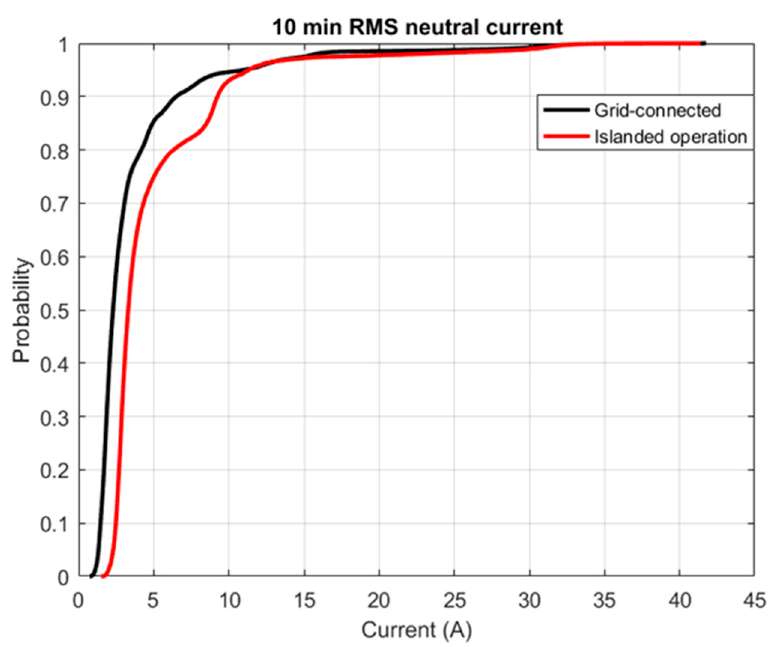
Figure 12. CDF for the 10 min RMS neutral current during islanded and grid-connected operation.